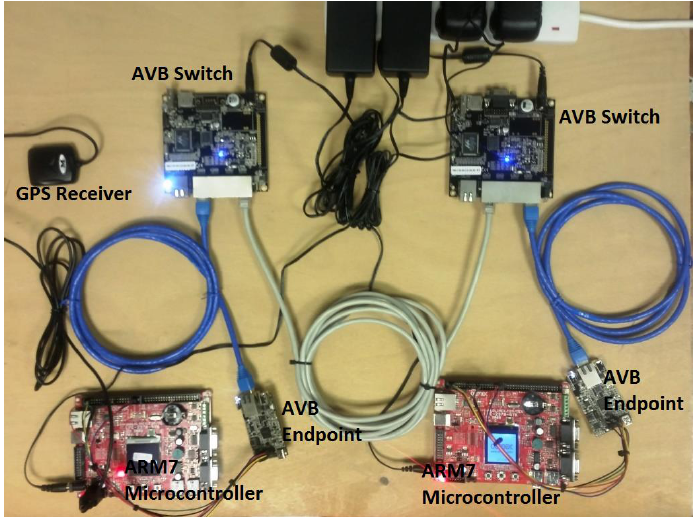
Figure 6. Photograph of testbed setup.